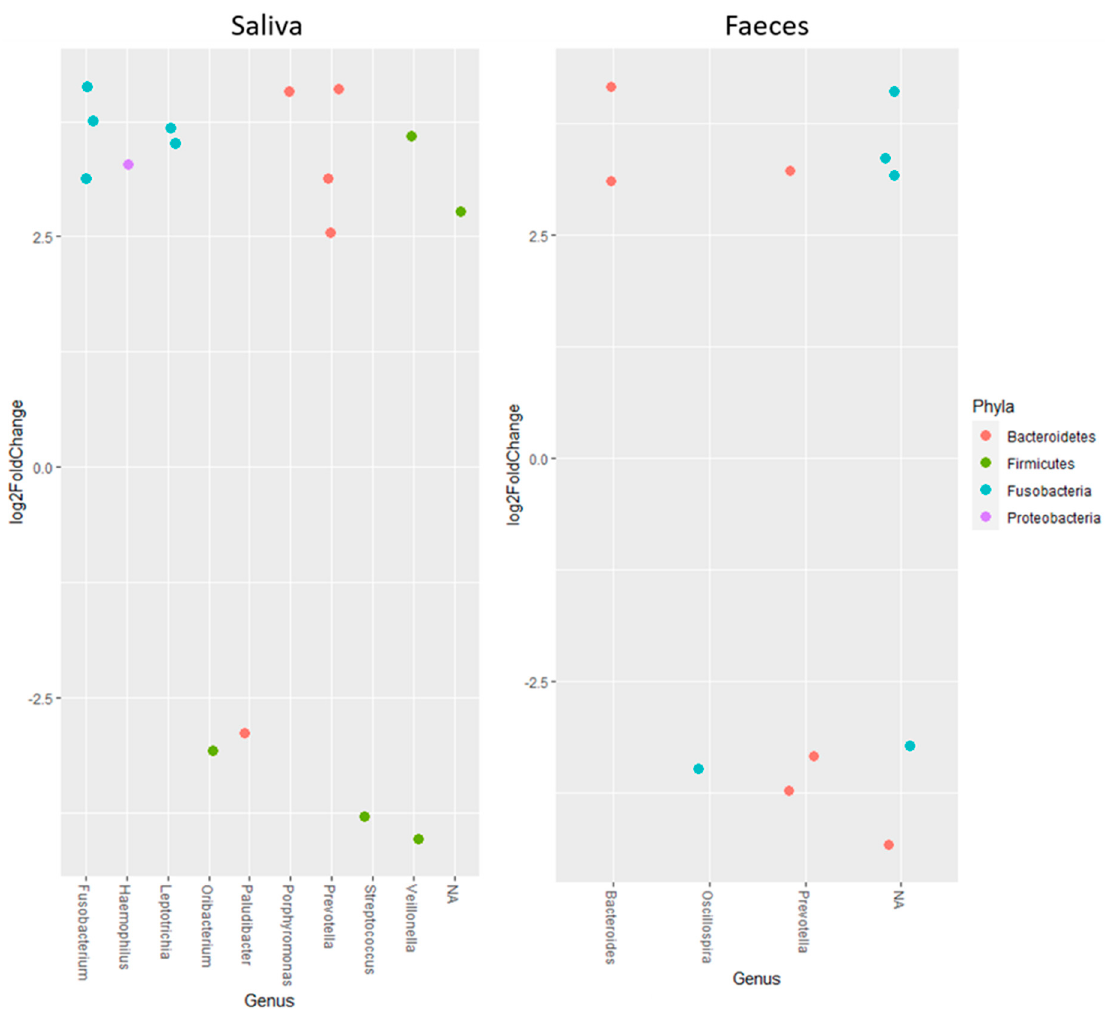
Figure 2. Log2FoldChange calculated as start vs. end for amplicon sequence variants belonging to different genera. All results in the figure are significant with p < 0.001. Positive changes indicate an increase over time, while negative values show a decrease.